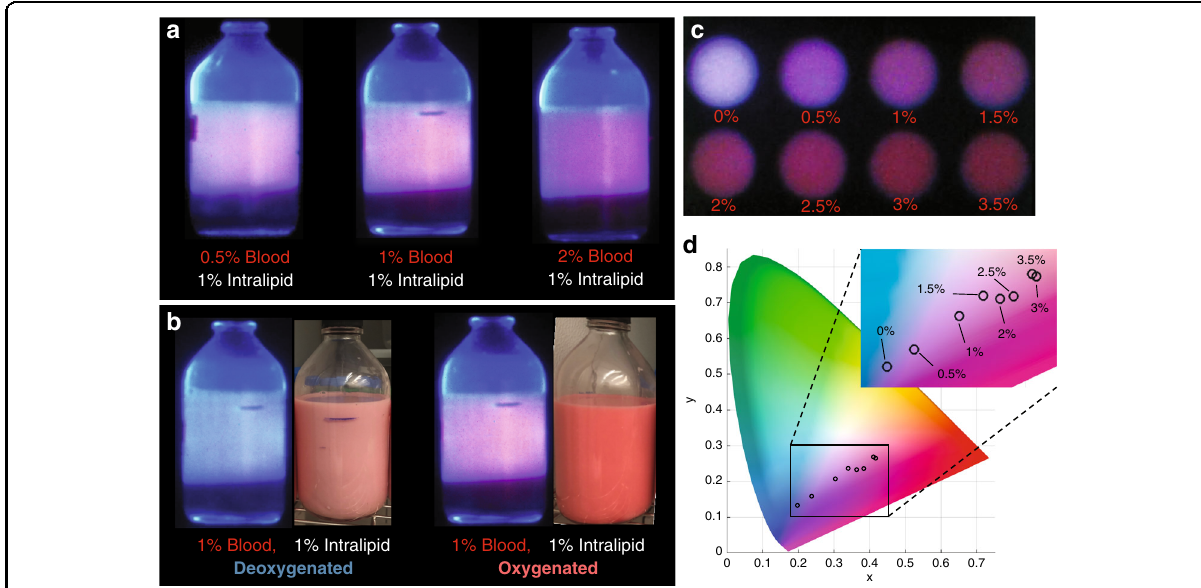
Fig. 3 Color change of cherenkov emission with varying tissue parameters. Varying blood concentration in aqueous solutions containing 1% intralipid to mimic tissue scatter impacts the color of Cherenkov emission from the samples, shown in a under irradiation with a 6 MV X-ray beam. In addition, increased oxygenation increases the signal in the red channel of the Cherenkov images shown in b due to the decreased absorption of red light by oxyhemoglobin compared with deoxyhemoglobin. Systematic variation of the blood concentration in small samples of 1% intralipid solution in c shows a near-monotonic distribution of colors along the red-to-blue axis when overlaid on a CIE chromaticity diagram in the xyY color space ( d